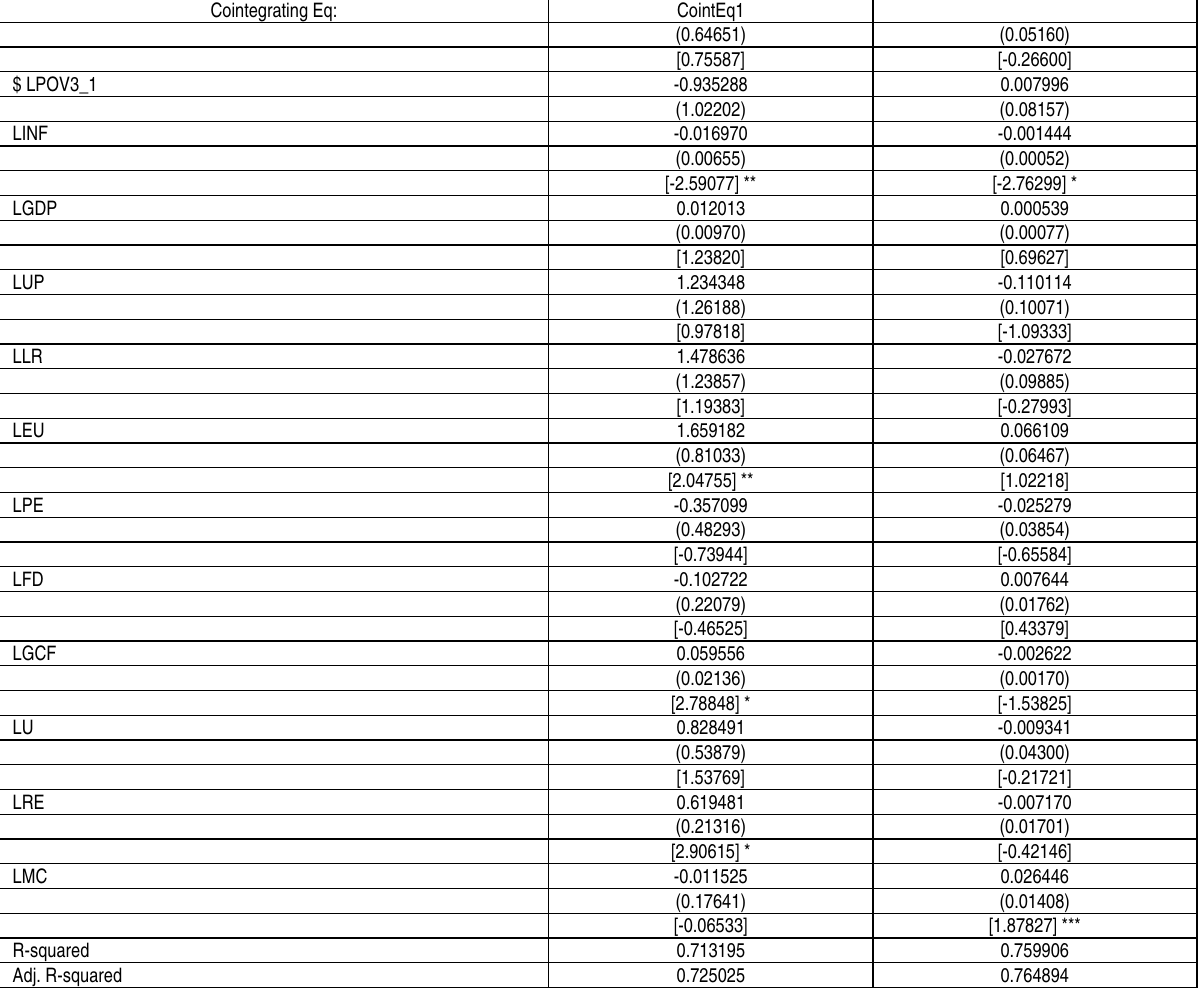
Table 7 (cont.). The ECM for variable LCO2 Cointegrating